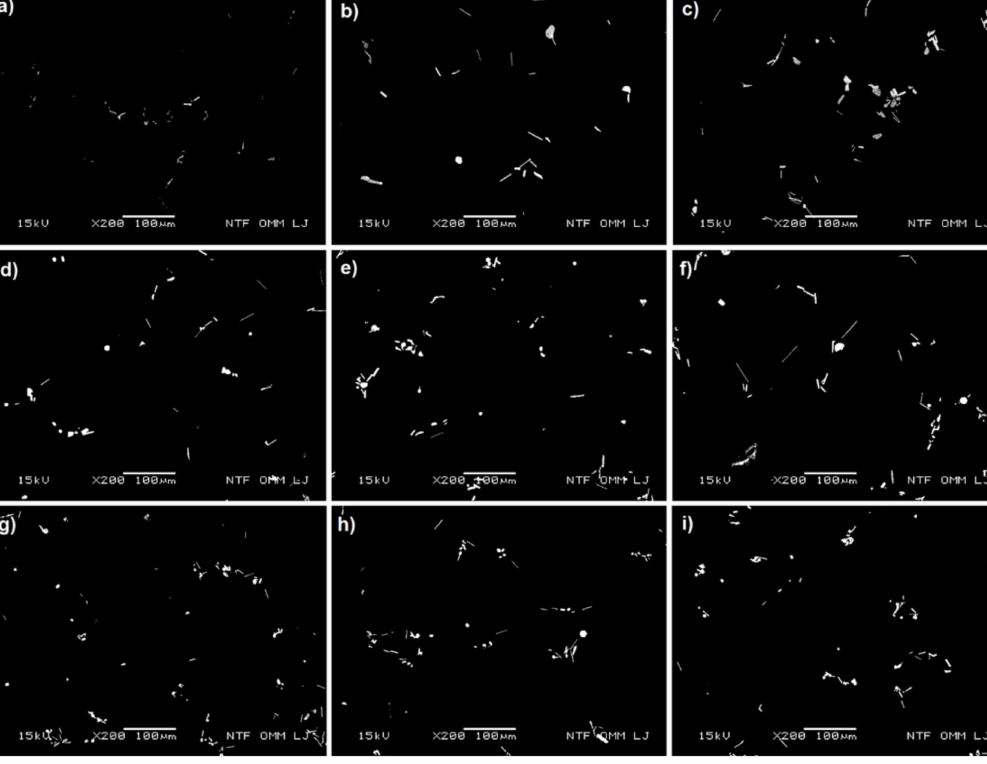
Figure 5. Microstructure of the samples (BEI). Mg 3 Bi 2 phases (bright areas) ( a ) 1M60, ( b ) 1M105, ( c ) 1M150, ( d ) 2M60, ( e ) 2M105, ( f ) 2M150, ( g ) 3M60, ( h ) 3M105, and ( i )